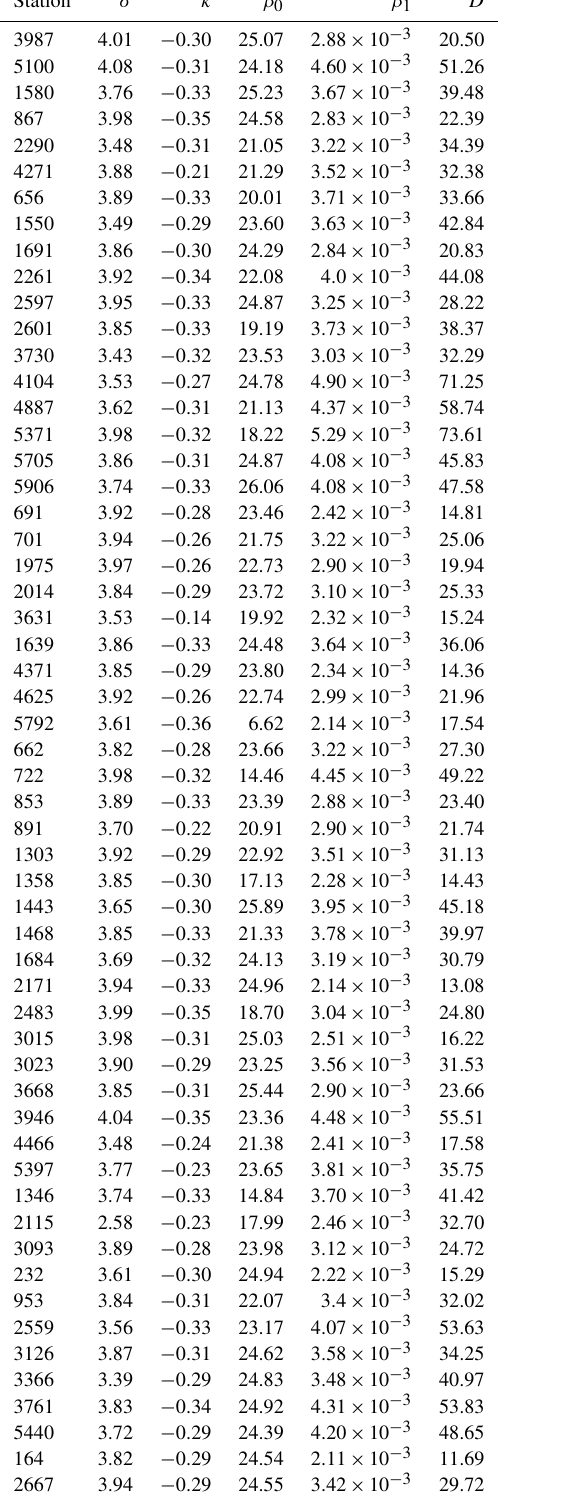
Table A3. MLE nonstationary models for temperature maxima. scale σ , shape k , location µ ( t ) = β 0 + β 1 × t , and likelihood D parameters. Here, t is 1